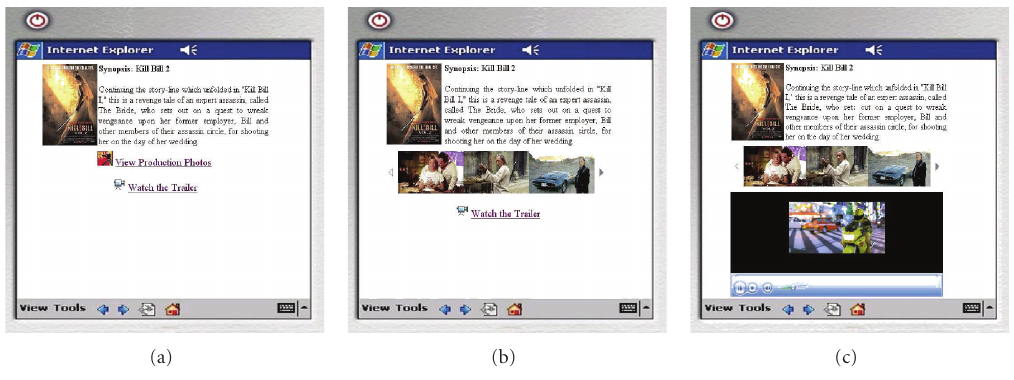
Figure 3: Basic ( T ), intermediary ( I ), and rich ( V ) versions of movie